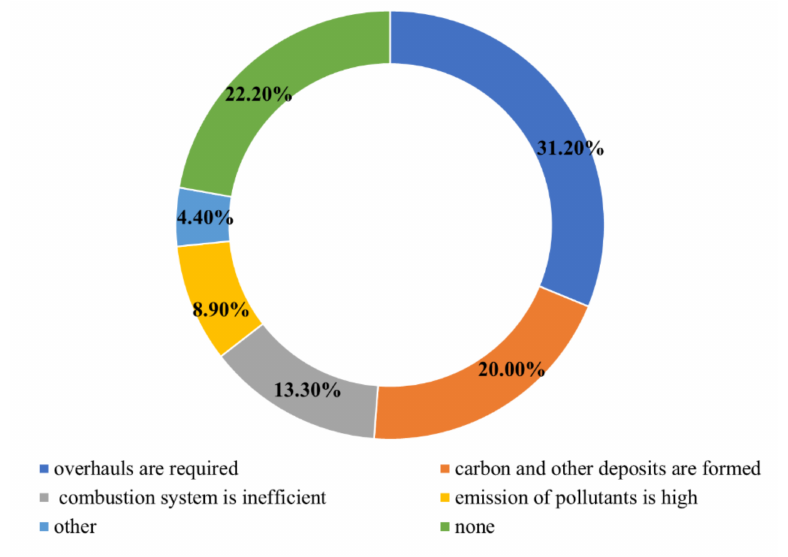
Figure 7. The most frequent problems in boiler